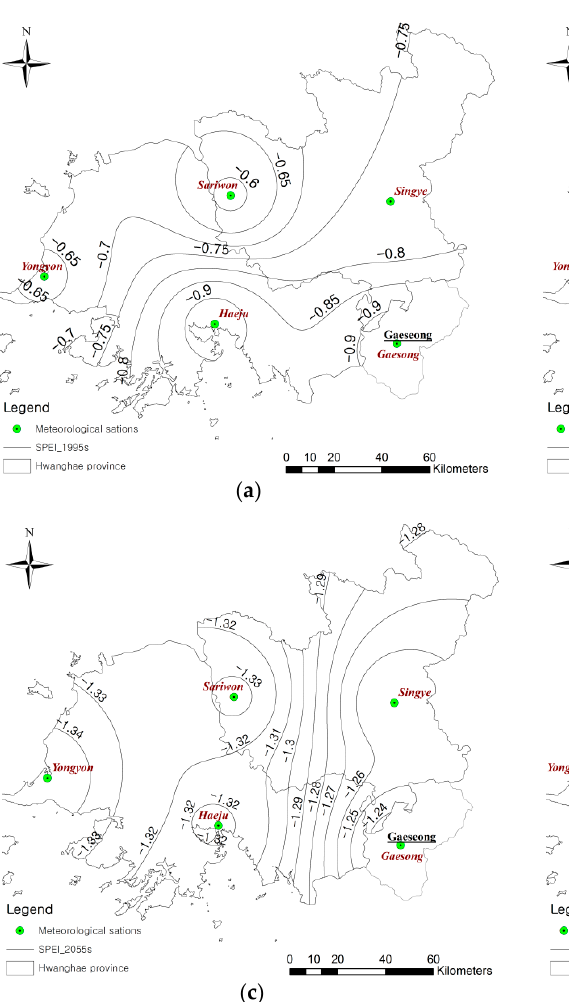
Figure 9. Contour lines of the one-month SPI for a ten-year return period: ( a ) 1995 (1981–2010); ( b ) 2025 (2011–2040); ( c ) 2055 (2041–2070); ( d ) 2085 (2071–2100).